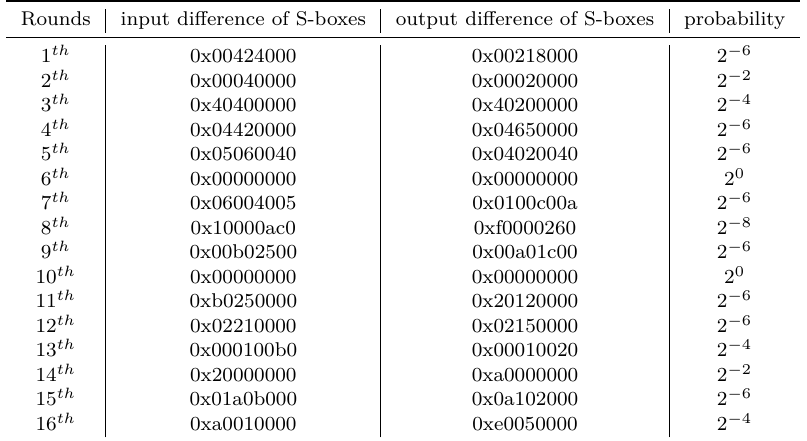
Table 14: The best differential characteristic with probability 2 − 72 for 16-round LBLOCK.